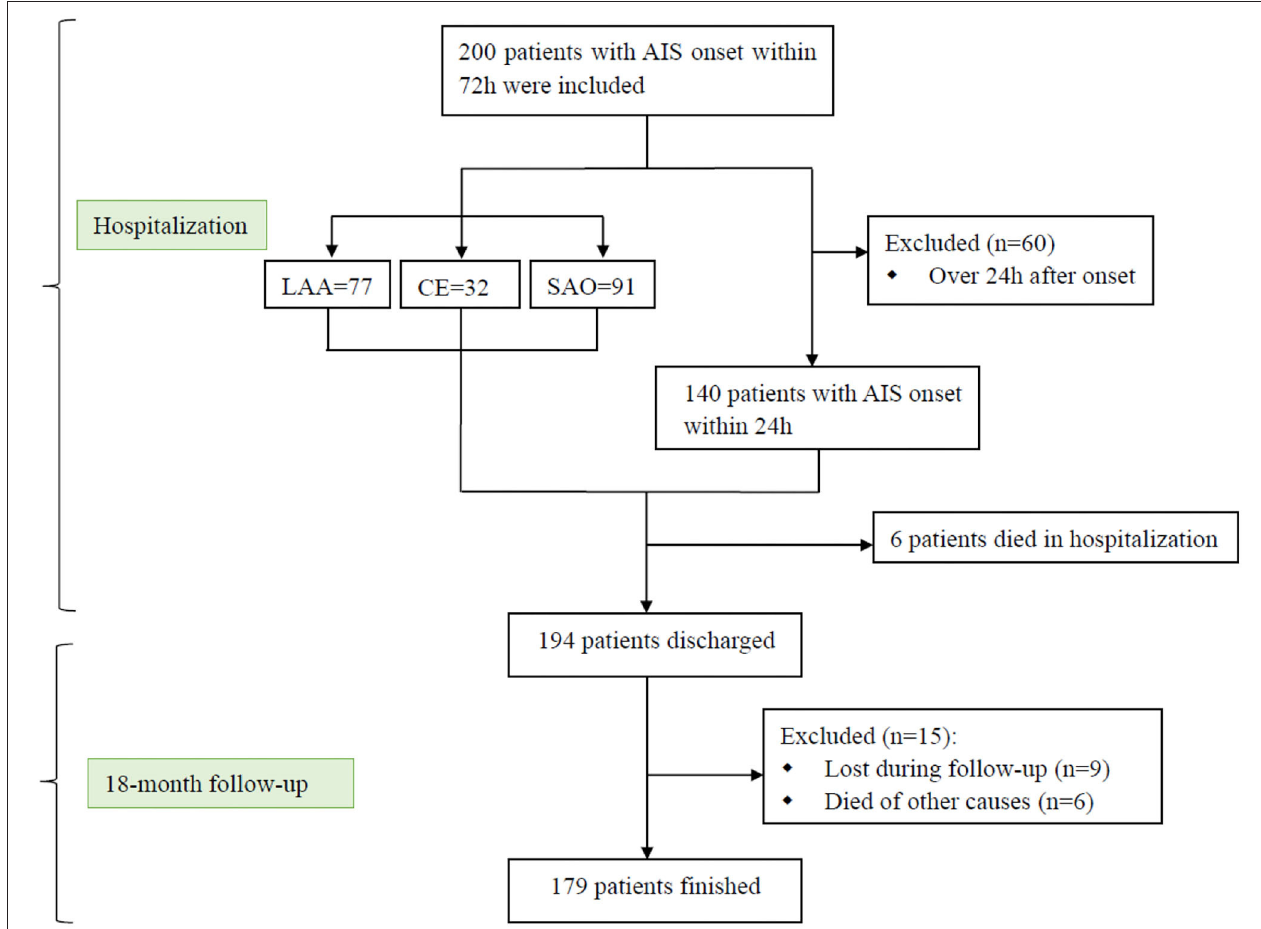
FIGURE 1 | Research flow chart. AIS, acute ischemic stroke; LAA, large artery atherosclerosis; CE, cardioembolism; SAO, small artery occlusion.